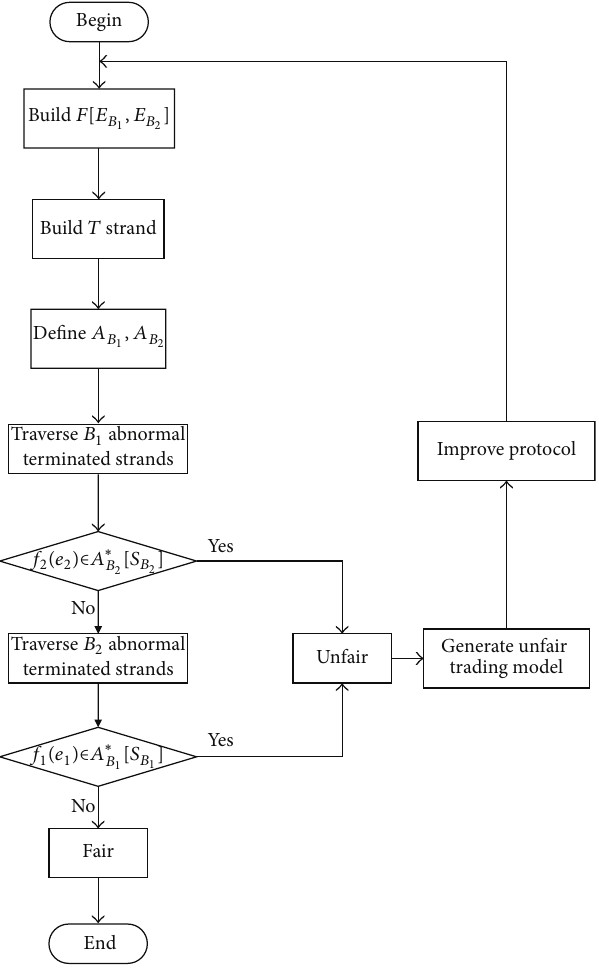
Figure 1: Fairness verification